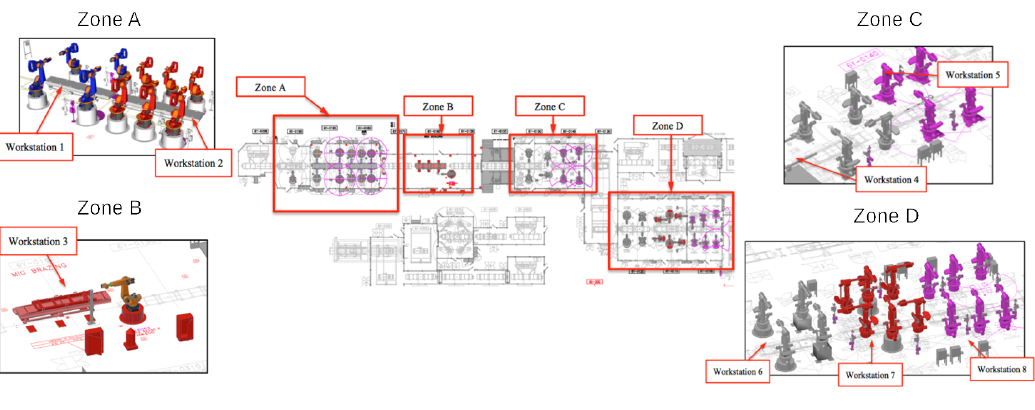
Figure 8. Welding line layout.